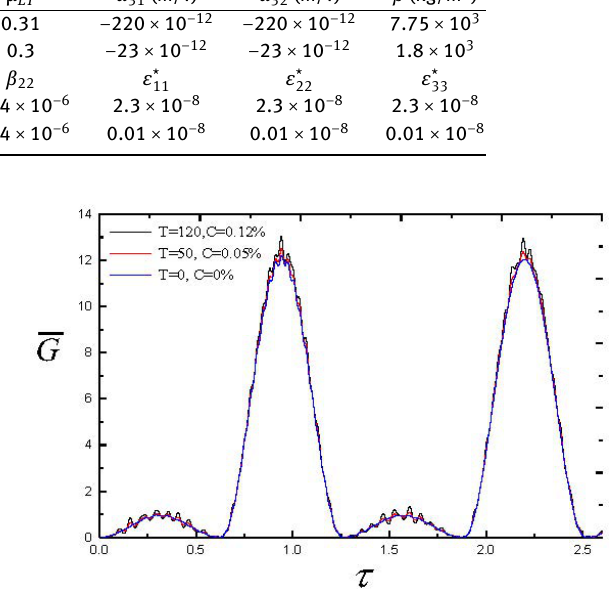
Figure 6. Effect of temperature and humidity on energy release rate of delaminated piezoelectric